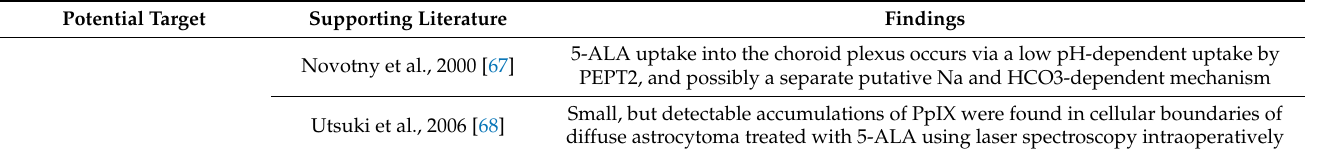
Table 1. Potential therapeutic targets in the 5-ALA fluorescence